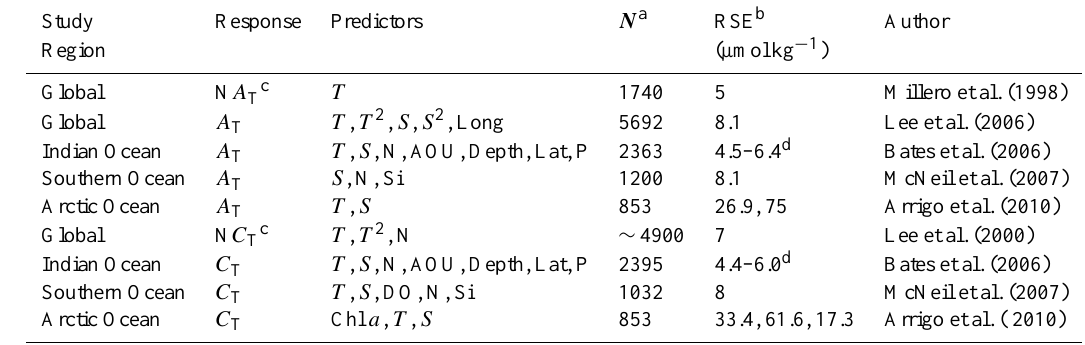
Table 1. Previous empirical approaches to constrain surface A T and C T distributions. T is temperature, S is salinity, DO is dissolved oxygen, AOU is apparent oxygen utilization, N is nitrate (NO − and Long is